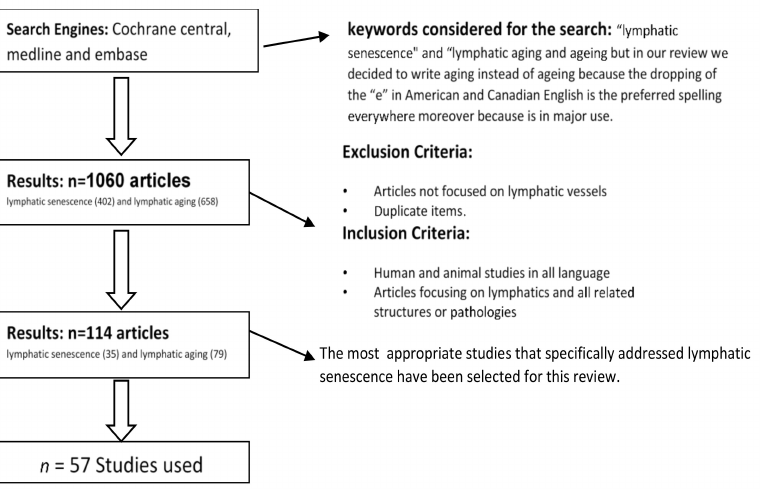
Figure 1. Flowchart of the literature selection process. The 57 most appropriate studies that specifi- cally addressed lymphatic senescence have been